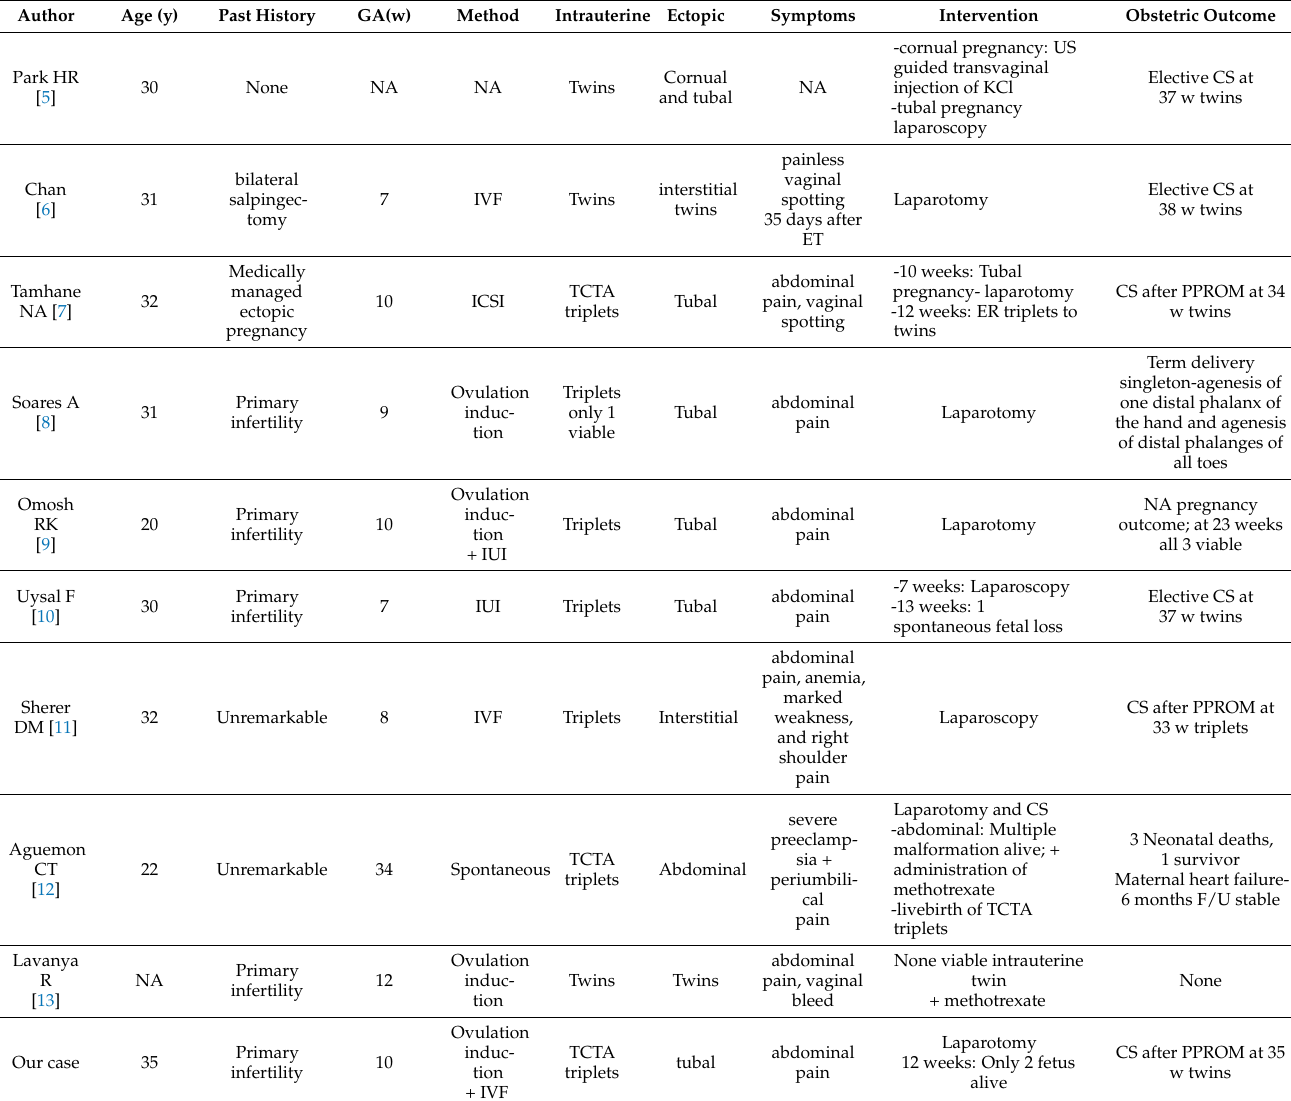
Table 1. Characteristics of included-case